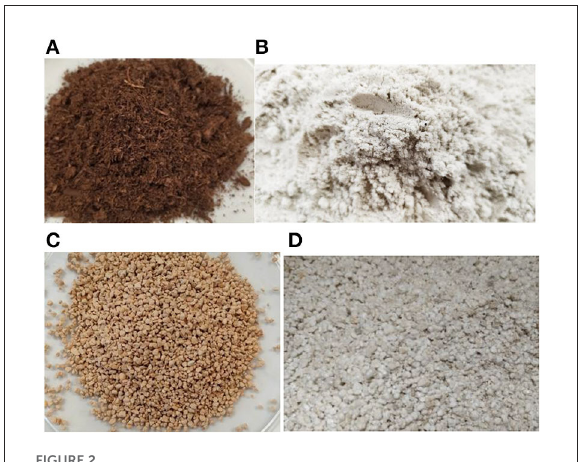
FIGURE2 Illustration of the tested samples. (A) Sorb 1, (B) Sorb 2, (C) Sorb 3, (D) Sorb 4.